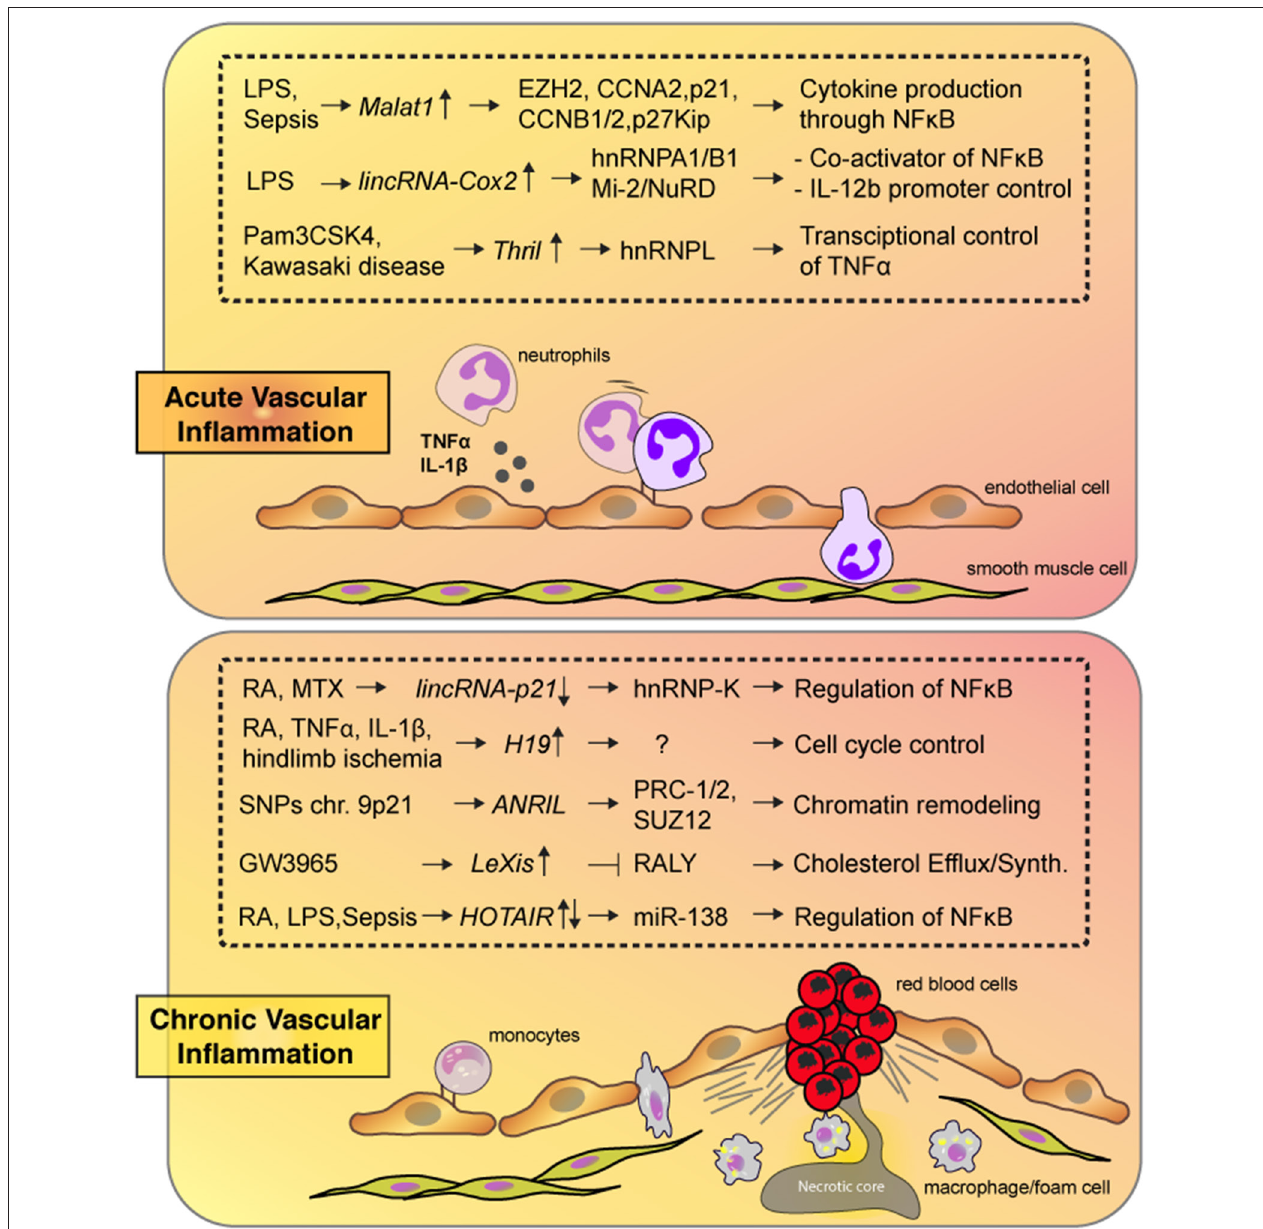
figuRe 1 | LncRNAs in acute and chronic vascular inflammation. Highlighted lncRNAs from the text are shown along with their targets and biological consequences in response to acute (top) or chronic (bottom) vascular